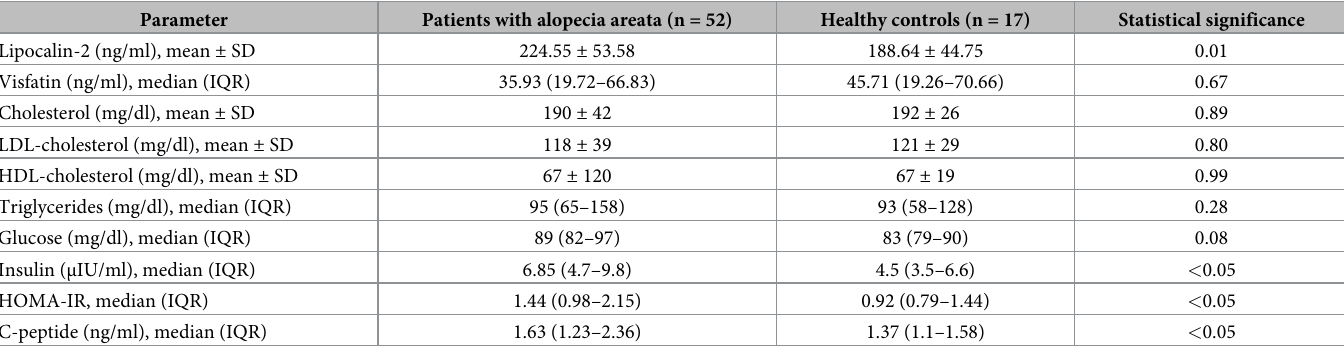
Table 2. Laboratory characteristics in patients with alopecia areata and the control